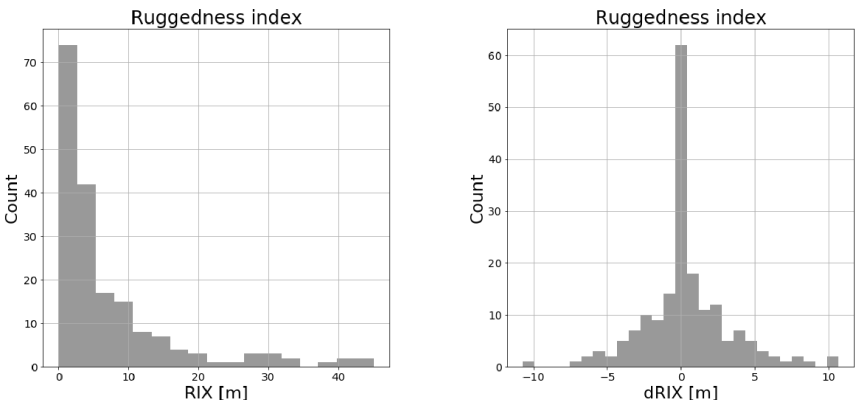
Figure 2. RIX and | (cid:49) RIX | for all 185 met masts. | (cid:49) RIX | is calculated using the closest neighbouring mast.